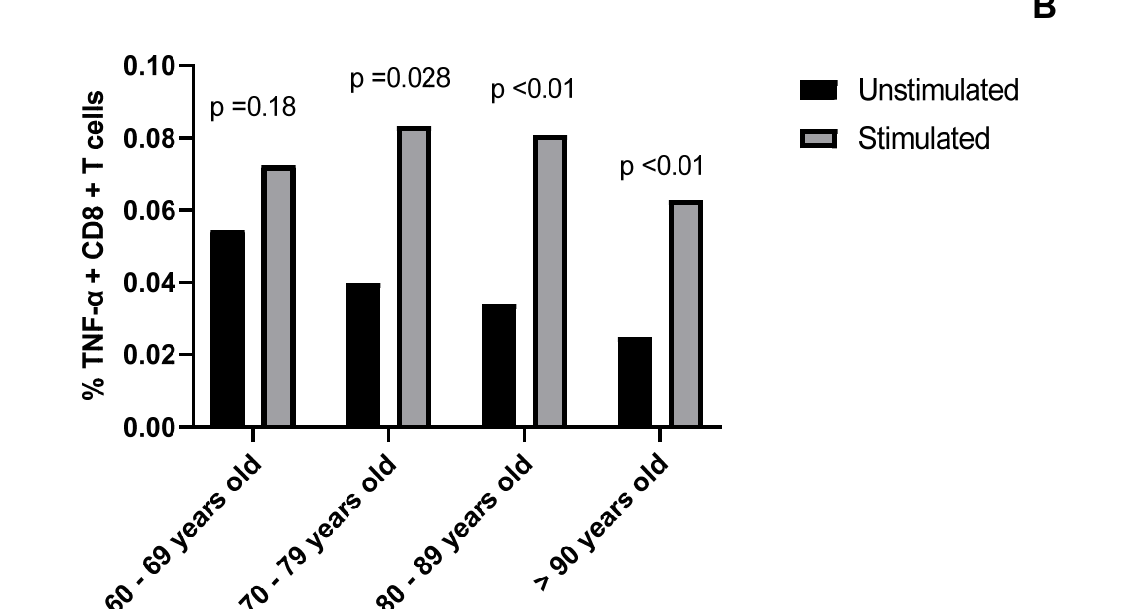
Figure 4. Determination of SARS-CoV-2-specific CD8 + T cell responses in Sputnik-V vaccinated individuals. PBMCs of individuals were stimulated with SARS-CoV-2-specific peptide pools. Per- centage of TNF − α + cells gated on CD8 + T cells was determined by flow cytometry. ( A ) Bar graph show frequency of CD8 + TNF − α + cells. ( B ) The graph shows the percentage of CD8 + TNF − α + cells following age group